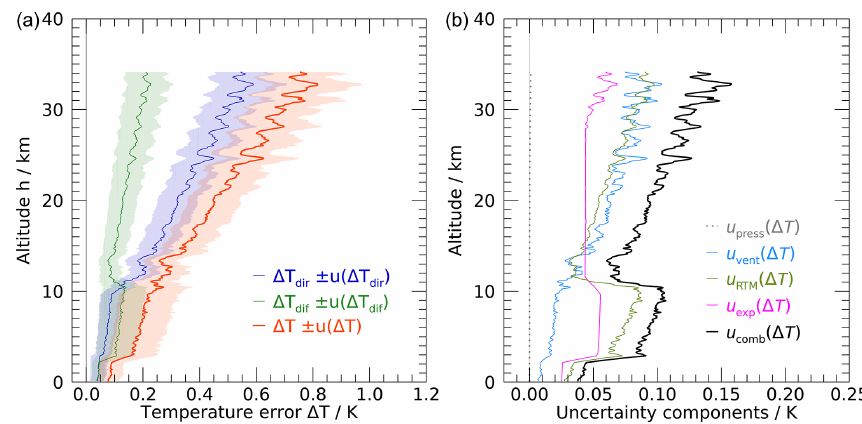
Figure 18. (a) Example for the estimated solar radiation error of temperature measurements (Lindenberg, 11 June 2020, 12:00UTC). Red: overall bias; blue: component from direct radiation; green: component from diffuse radiation; shaded areas indicate uncertainties ( k = 1). (b) Uncertainty components ( k = 1) associated with pressure, ventilation speed, radiation model, and laboratory experiments.